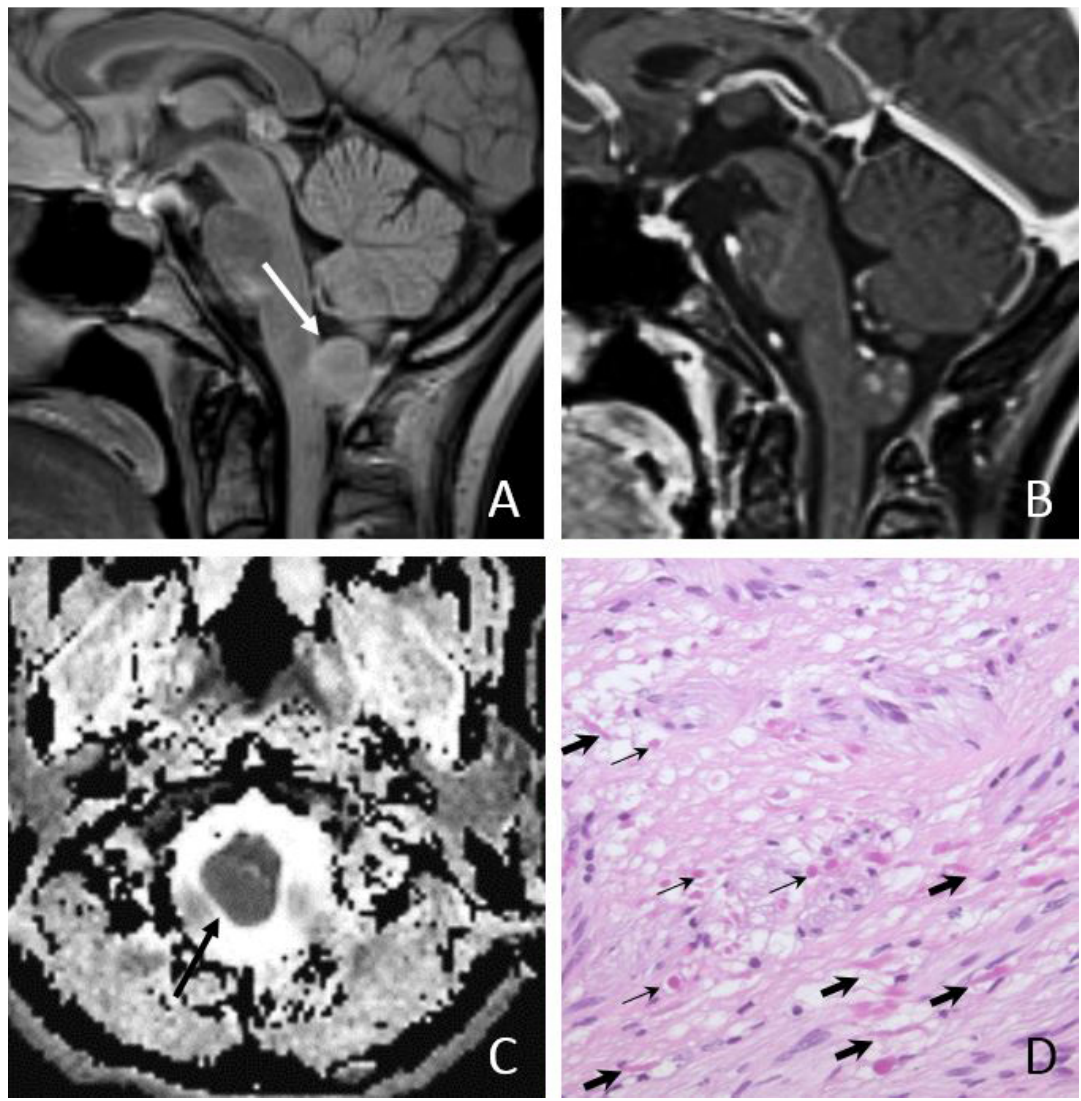
Fig. 3. Case 3. Exophytic aPA. Sagittal plane reconstructed 3D T2-FLAIR (A) shows a solid, exophytic mass originating from the dorsal aspect of the medulla and growing into the cisterna magna (arrow). The mass presents substantial T2-FLAIR signal isointensity compared to the cerebellar cortex, and a patchy enhancement after gadolinium injection (B). On the ADC map (C) the lesion showed minimally increased diffusivity (arrow), as compared to the medulla. Microscopically (D) this tumor exhibits a loose, fibrillary matrix rich in Rosenthal fibers and eosinophilic granular bodies (thin arrows), comprising elongated, spindle cells, without relevant atypia (thick